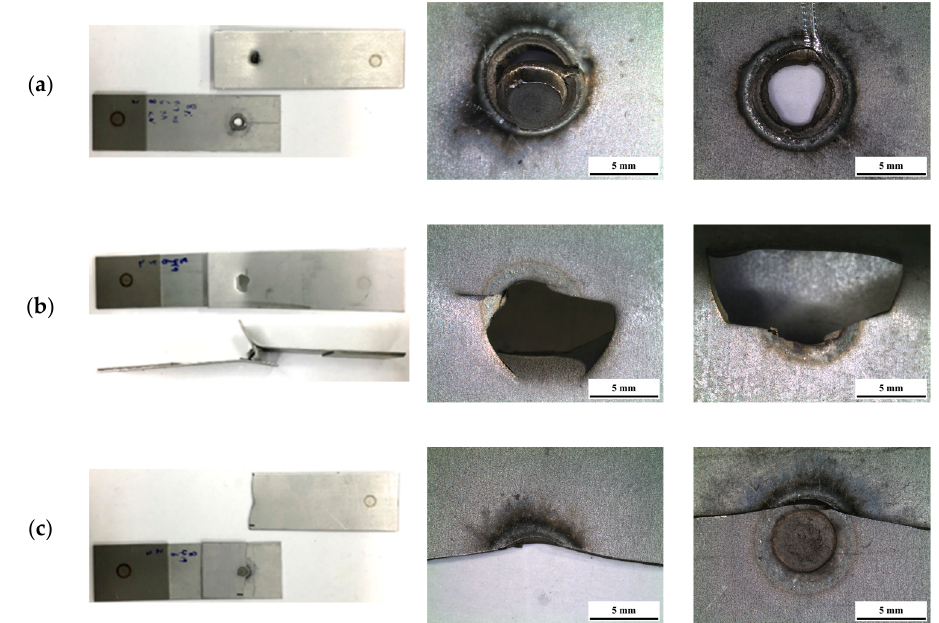
Figure 8. Failure shapes with various failure modes at electrode face diameter of 8 mm: ( a ) pull-out failure, ( b ) plug failure, and ( c ) HAZ failure.